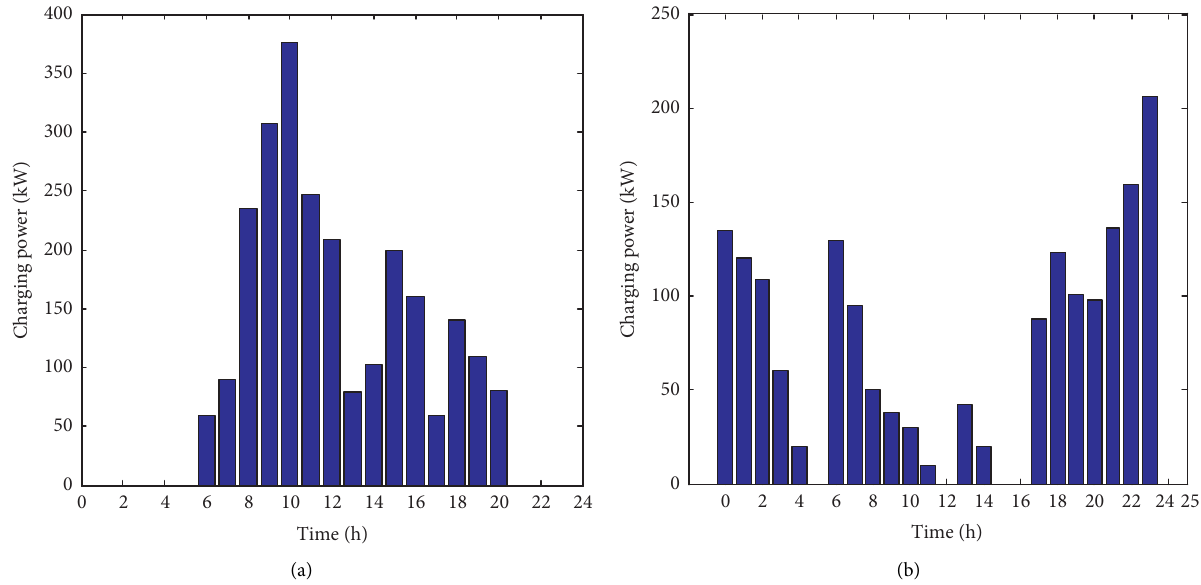
Figure 11: Charging power distribution before and after optimization of 150